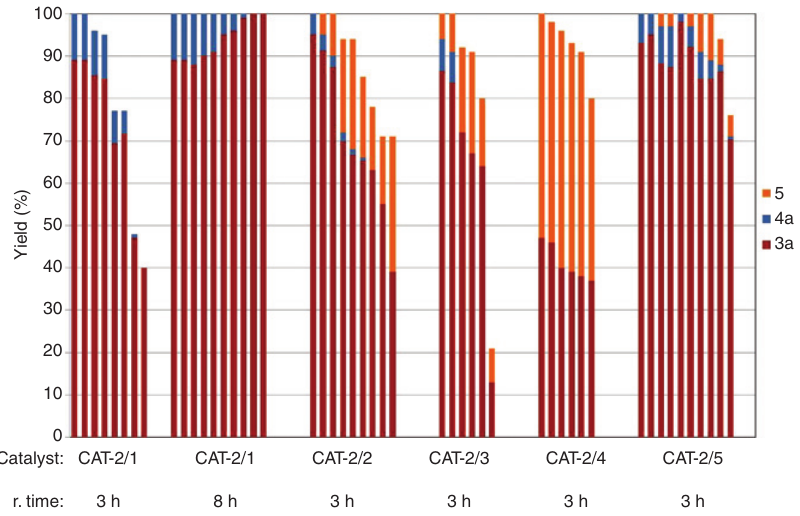
Figure 4: Selectivity and recyclability of catalysts immobilised on SILP-2 in aminocarbonylation carried out in DMF [0.2 mmol 1 , 0.5 mmol